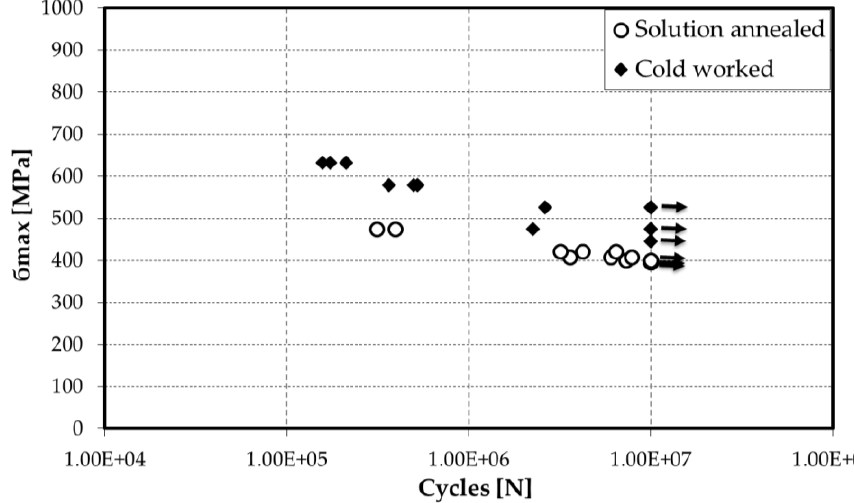
Figure 3. Plot of an S-N curve for S31673 at room temperature in the solution annealed and cold worked condition.